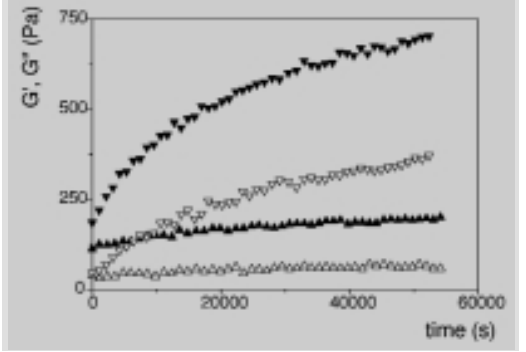
Figure 14 (left): Storage ( Û , Ú ) and loss ( ı , Ù ) modu- lus at 0.1 rad/s versus reac- tion time at 150°C for the diacid ( Û , ı ) and acid-amine COPA blends. Figure 15 (right): Storage ( Û , ı , · ) and loss ( ‚ ) modu- lus at 0.1 rad/s versus reac- tion time at 150°C for the diacid ( Û ), acid-amine ( ı ) and diamine ( · , ‚ ) COPA